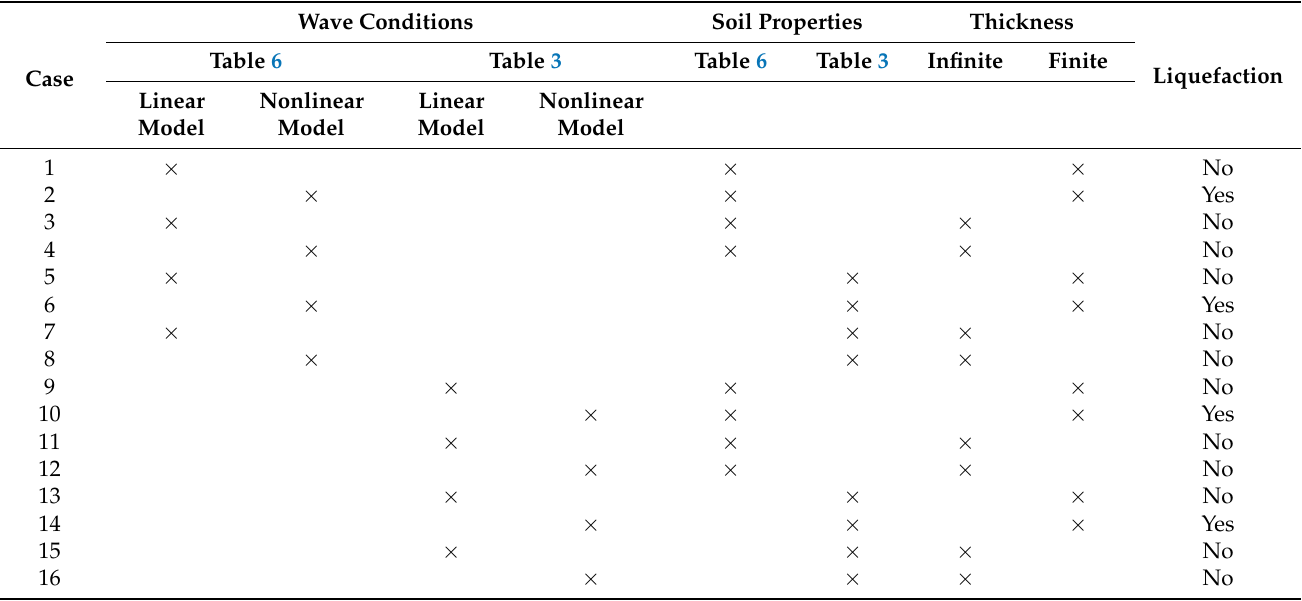
Table 5. Calculated liquefaction results for two wave conditions, two TIP soil properties, and two thicknesses ( S r =